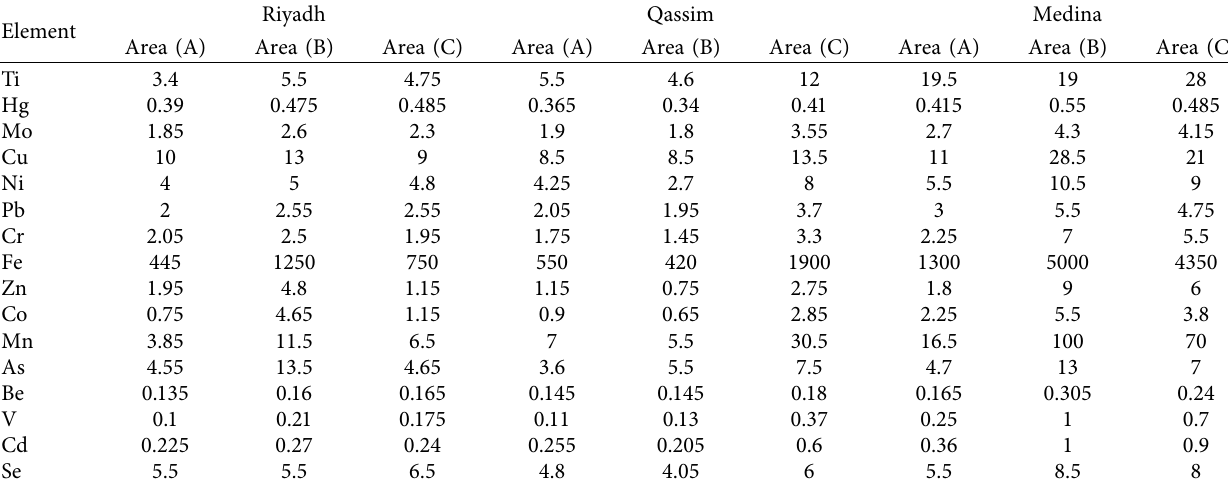
Table 2: Results of heavy element concentration (mg/kg) at sites A, B, and C of Riyadh, Qassim, and Medina regions. Riyadh Qassim Medina Element Area (A) Area (B) Area (C) Area (A) Area